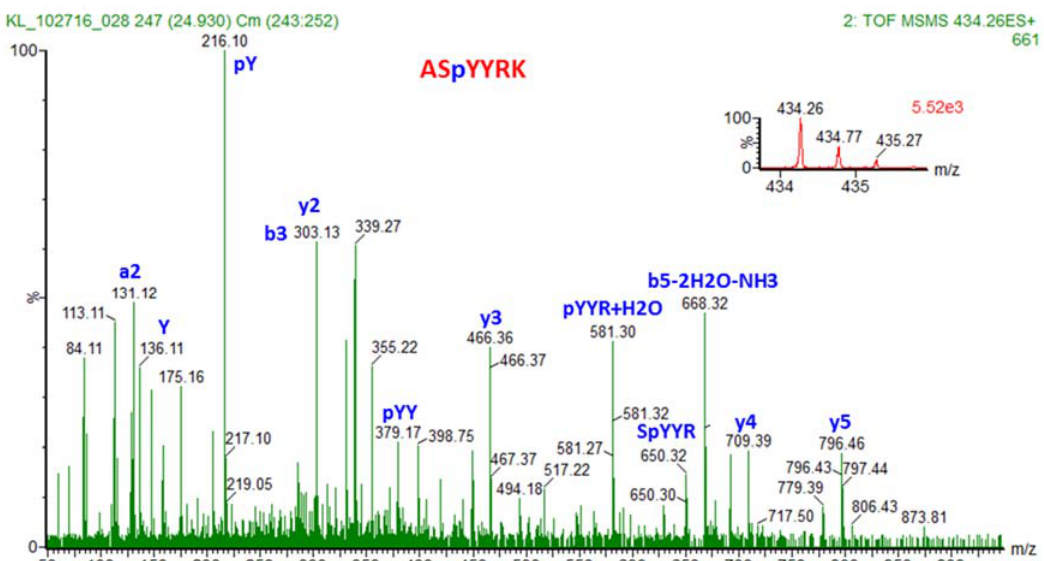
Figure 5. MS spectrum of the precursor ion with m/z of 434.26 (2+), shown in the inbox figure, which corresponds to phosphorylated peptide ASpYYRK. Note that pY corresponds to phosphorylated tyrosine residue. Fragmentation of the precursor ion in MS/MS produced a series of fragment ions that correspond to the phosphorylated (bottom) peptide. From three potential amino acids that are phosphorylated (one serine and two tyrosine residues, all neighbors within the peptide sequence ASYYRK, only one tyrosine is phosphorylated, and not the second tyrosine, not the serine residues. This is clearly demonstrated by y3 ion, where tyrosine from the sequence YRK is not phosphorylated, y4 ion, where the second tyrosine from the sequence YYRK is phosphorylated (pYYRK) and y5 ion, where serine residue is not phosphorylated. The m/z of the precursor ion indicated that there is only one phosphate group on this peptide ASYYRK (namely ASpYYRK). Therefore, tandem mass spectrometry is highly specific in locating a specific modification within a peptide of a particular amino acid sequence. Reproduced from Reference [205].